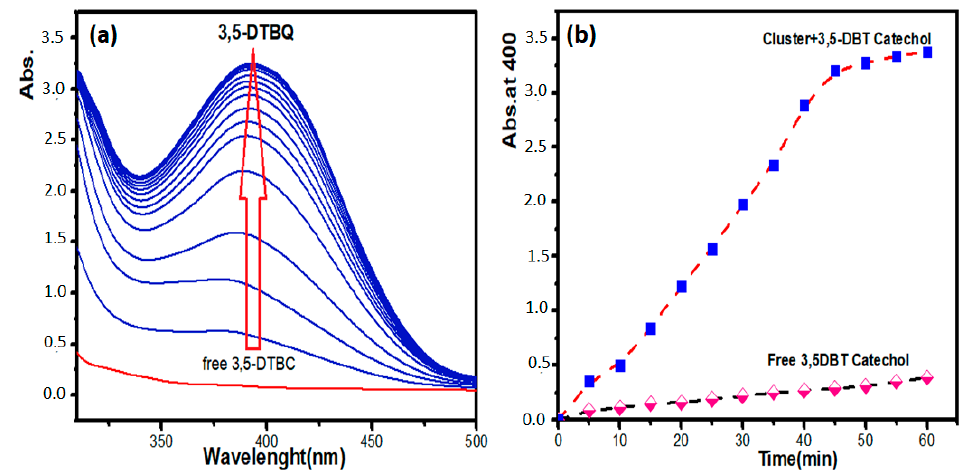
Figure 8. Time-dependent 3.5-DBT oxidation process: ( a ) abs. vs. λ , and ( b ) abs. vs. t . Scheme 2. Cluster catalytic oxidation of catechol to O-quinone.